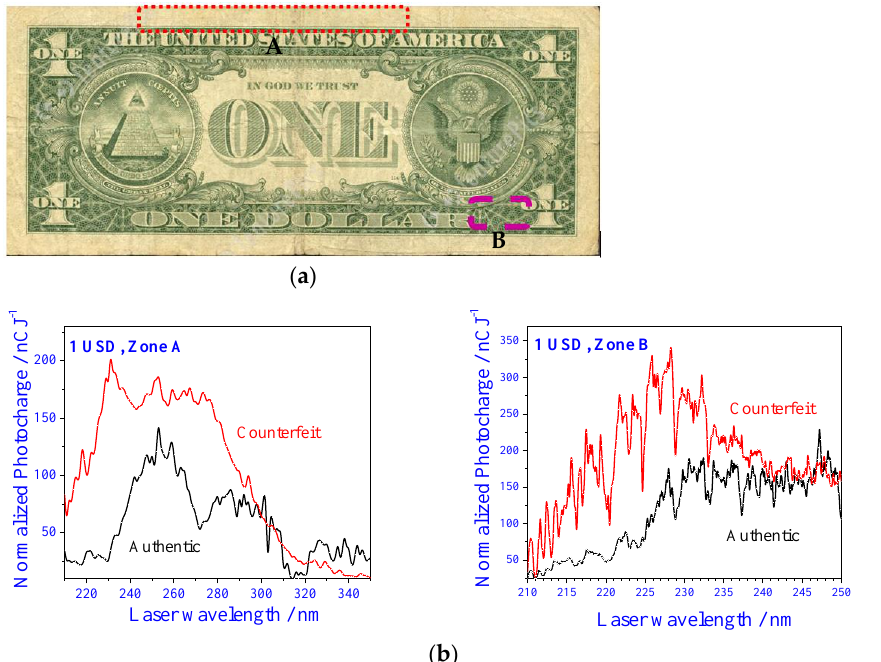
Figure 4. ( a ) The two analyzed zones in 1-dollar banknote; ( b ) MEES spectra of authentic and coun-